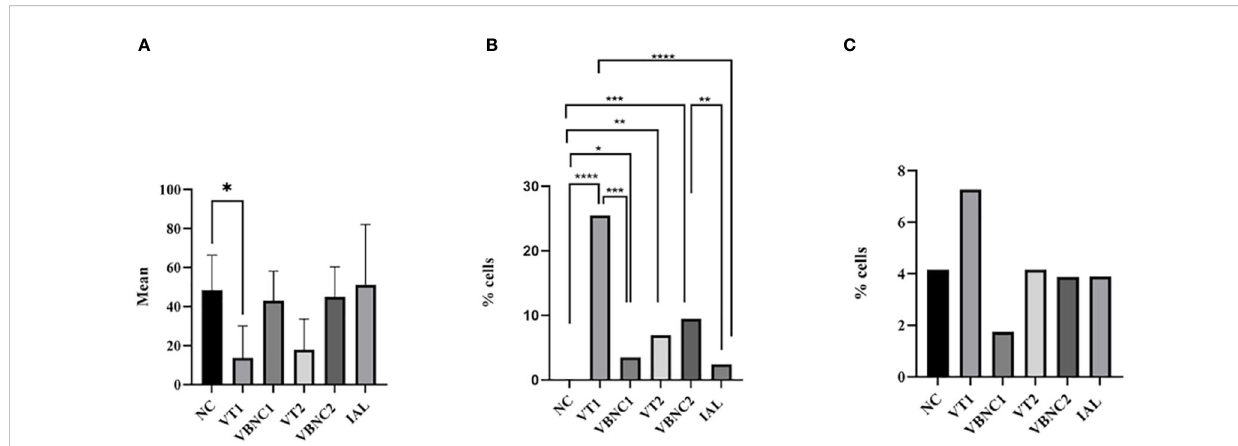
FIGURE 5 Mean of total cells (A) and percentage of cells in apoptosis (B) or necrosis (C) . We considered the cells marked with DAP as the total number of cells. The apoptotic cell index was calculated by the ratio between the number of cells that were stained only by green and blue. The percentage of necrotic cells was calculated by the ratio between the number of cells stained in red and blue. We used ANOVA followed by the Tukey test, comparing each group with the negative control group. We used the chi-square and Fisher ’ s tests, followed by binomial between two proportions for apoptosis and necrosis analyses, comparing each group with the negative or positive group or typical and VCN form (< 0.05). NC, negative control. VT1, VT2: C. jejuni VT. VBNC1, VBNC2: C. jejuni VBNC. *p < 0.05; **p < 0.01; ***p < 0.001 and ****p <